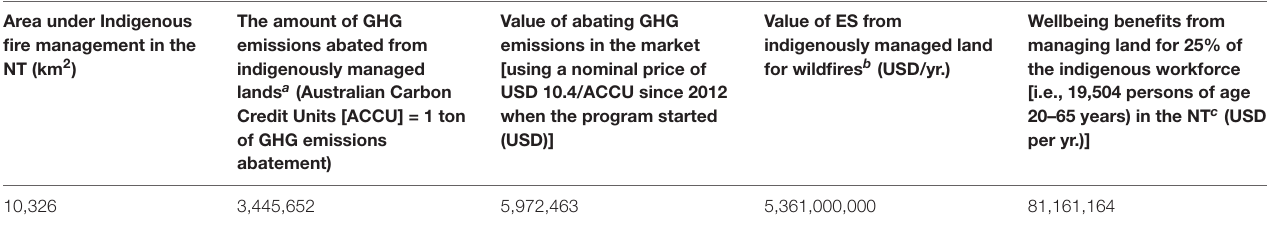
TABLE 1 | The value of GHG emission abatement, ES, and wellbeing benefits from Indigenously managed land in the NT, Australia. Area under Indigenous fire management in